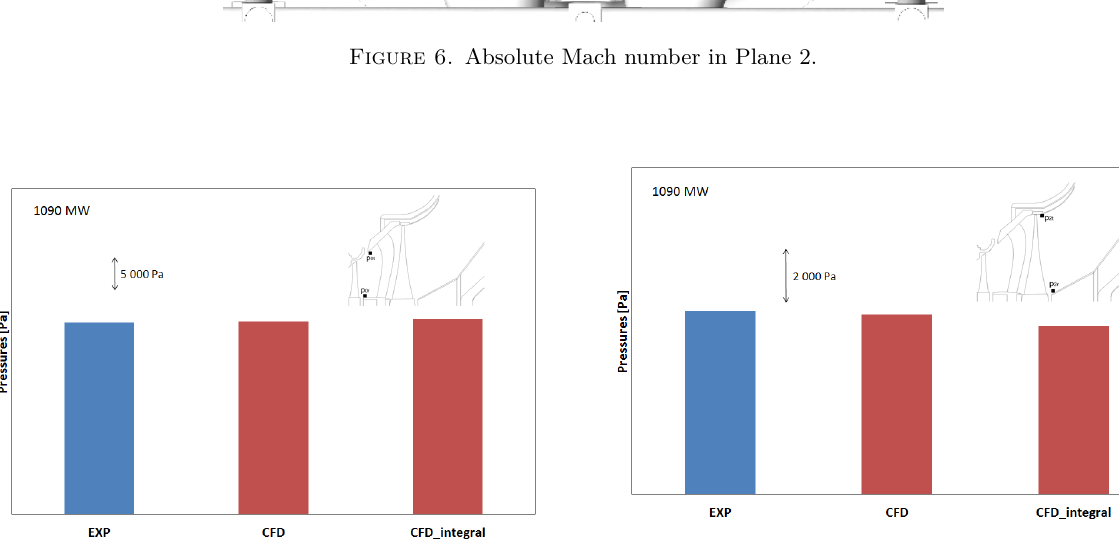
Figure 7. Static pressures in Plane 0.